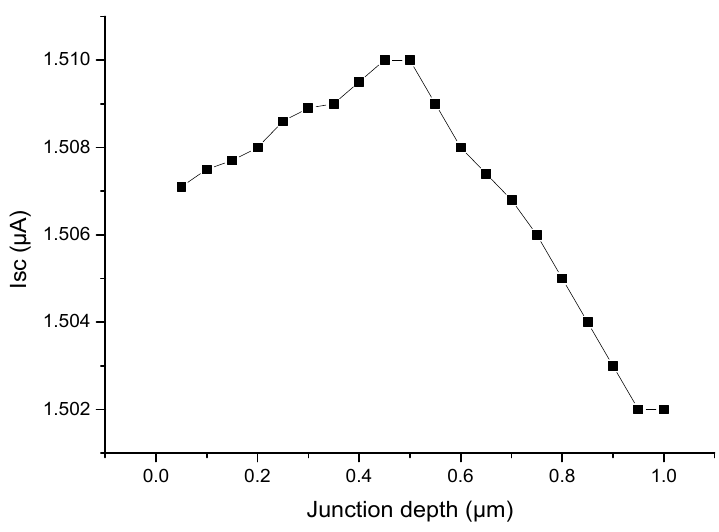
Figure 5. Relationship between I SC and junction depth in Si– 147 Pm.